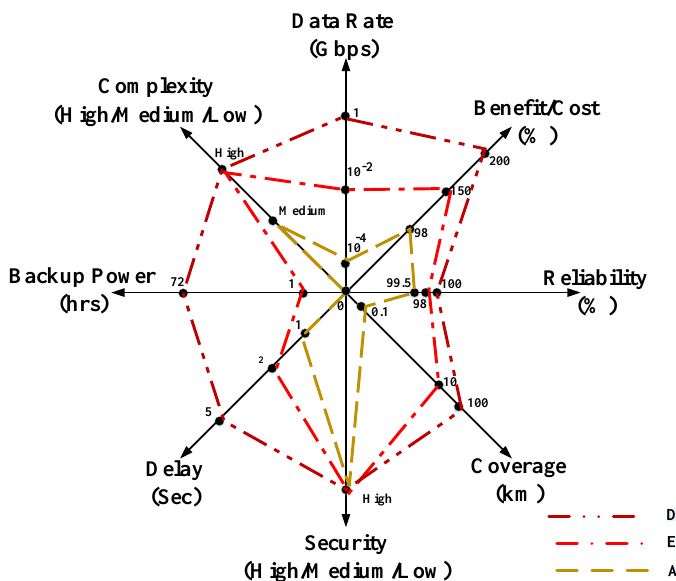
Figure 3. Comparison of MG control levels characteristics.